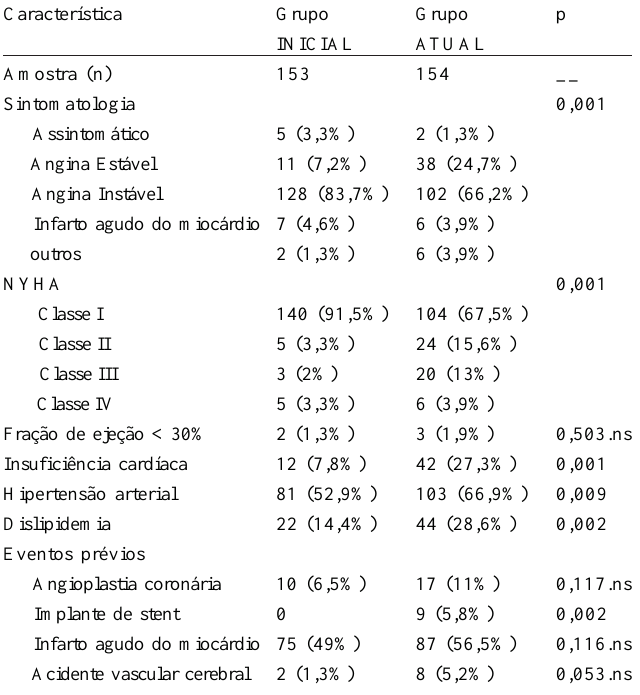
Tabela 2. Caracterização da doença cardíaca nos pacientes considerados no estudo.